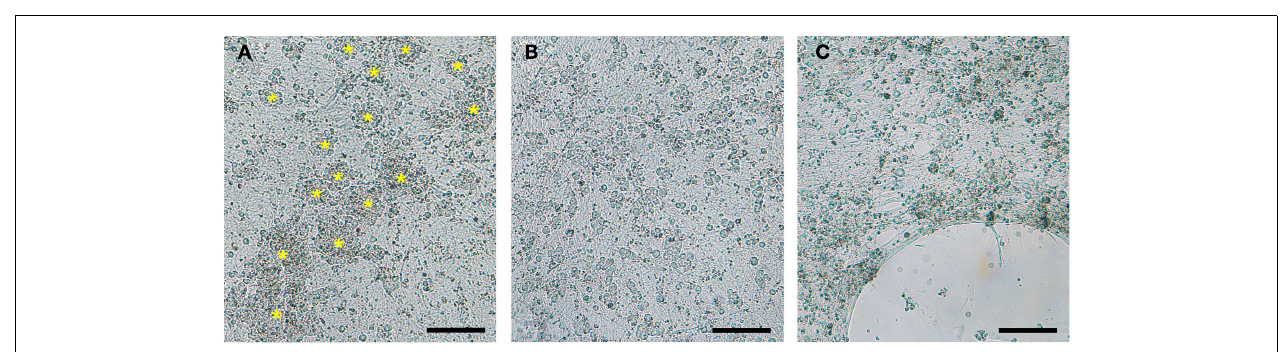
monolayers. (C) Detachment of DRG neurons cultured on poly-lysine and poly-ornithine alone or in combination with laminin observed after 6 DIC. DRG neurons seeded at 50,000 cells/well in a XF24 polystyrene microplate imaged at 7 DIC with a 5 × phase objective. Scale bar: 200 µ m.